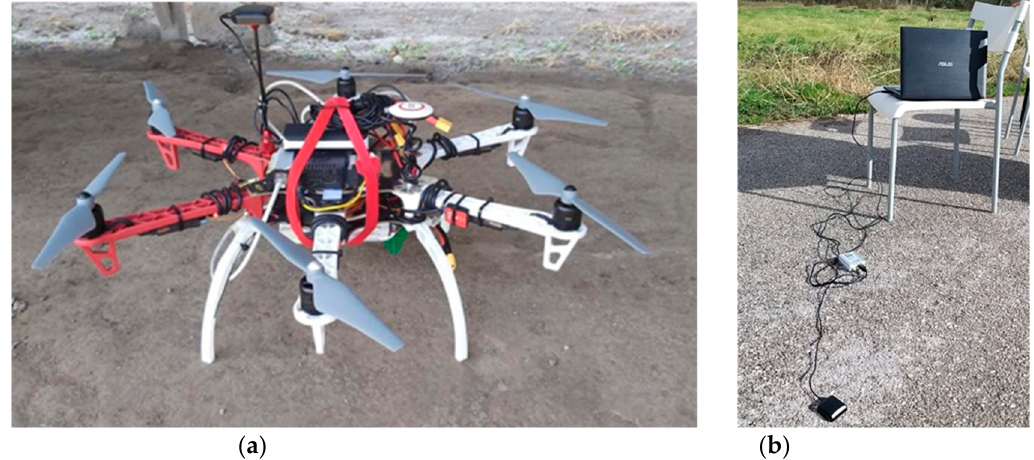
Figure 1. M-UAV radar imaging system: ( a ) hexacopter with onboard equipment; ( b ) ground-based GPS station.